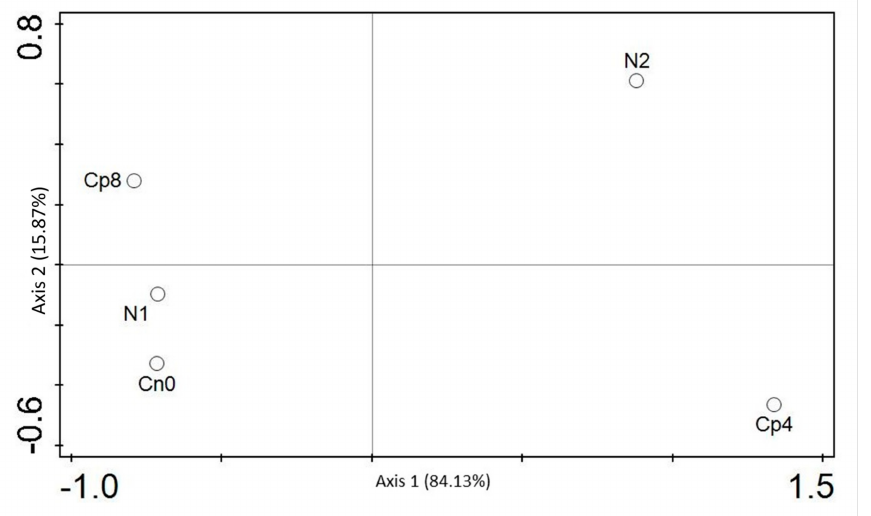
Figure 7. Principal coordinate analysis for the disease suppressive genes present at the maize rhizosphere under fertilization treatments. Cn0 (control), Cp8 (8 tons/ha compost ma- nure), Cp4 (4 tons/ha compost manure), N2 (120 kg/ha inorganic fertilizer), and N1 (60 kg/ha inorganic